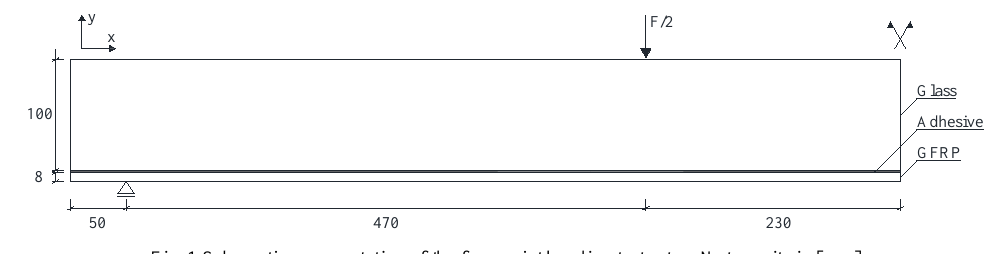
Fig. 1 Schematic representation of the four-point bending test setup. Note: units in